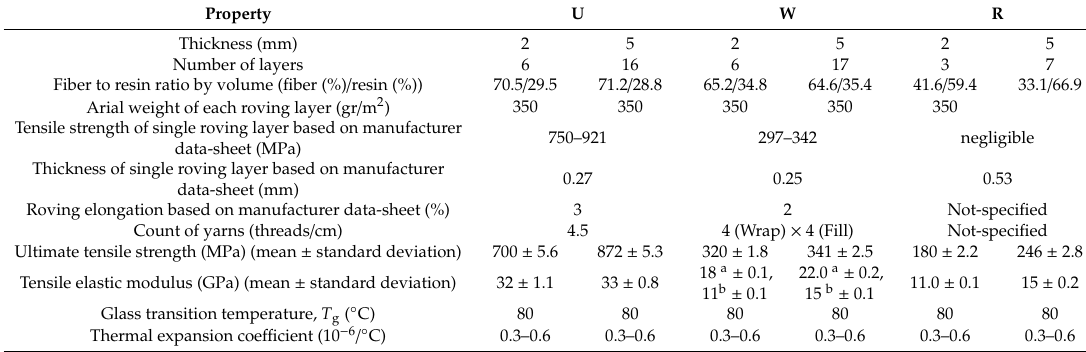
Figure 1. Di ff erent types of glass fiber reinforced polymer (GFRP) laminates used in this study: ( a ) Continuous unidirectional fibers, ( b ) continuous woven fibers and ( c ) chopped strand fibers. Table 1. Characteristics of GFRP laminates constructed by vacuum infusion process (VIP) method. Property U